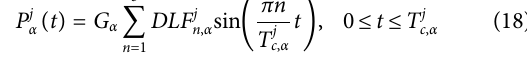
Frontiers in Built Environment |